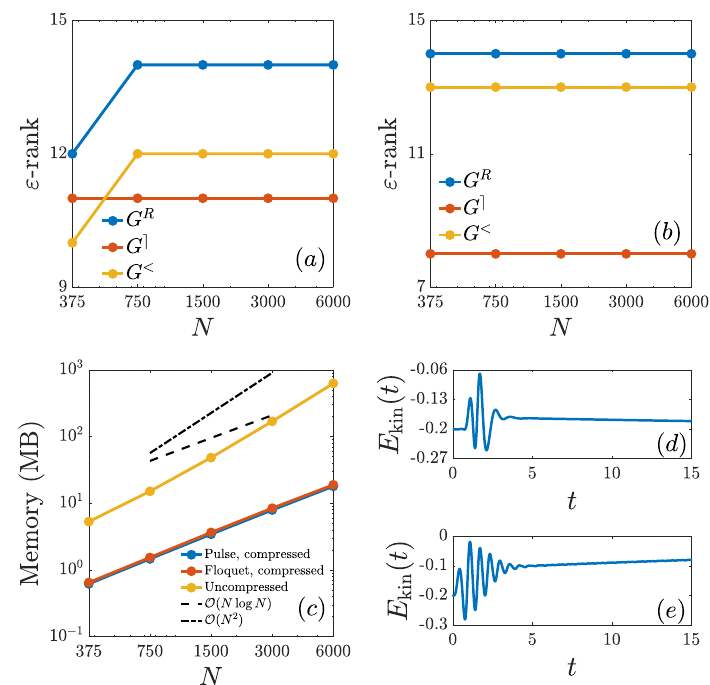
Figure 10: Ranks and memory usage for the DMFT examples with increasing propa- gation times T corresponding to N time steps of fixed size ∆ t , computed offline from solutions obtained using the NESSi library. The plots are analogous to those shown for the GW examples in Fig.